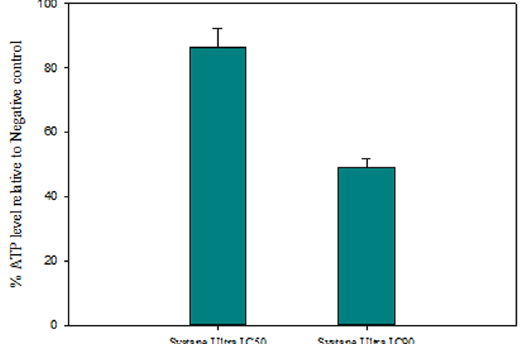
Figure 7. The effect of Systane Ultra on the ATP content, using CellTiter-Glo Luminescent Cell Viability Assay. Results are representing in percentage relative to the negative control. Cells were treated by the IC 50 and IC 90 concentration for 24